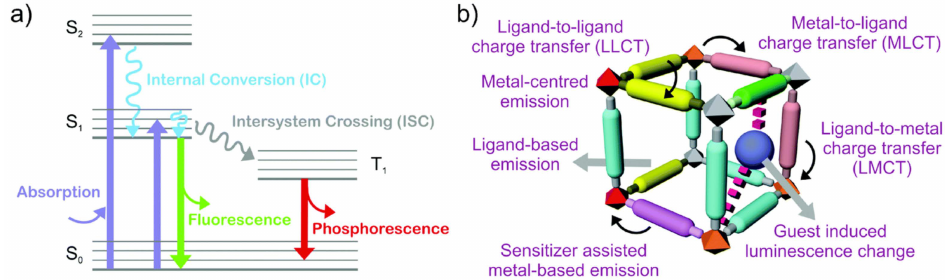
Figure 7. ( a ) Schematic illustration of di ff erent photo-physical processes, and ( b ) representation of the di ff erent options related to the optical emission of MOFs. Reprinted with permission from [71]. Copyright The Royal Society of Chemistry,